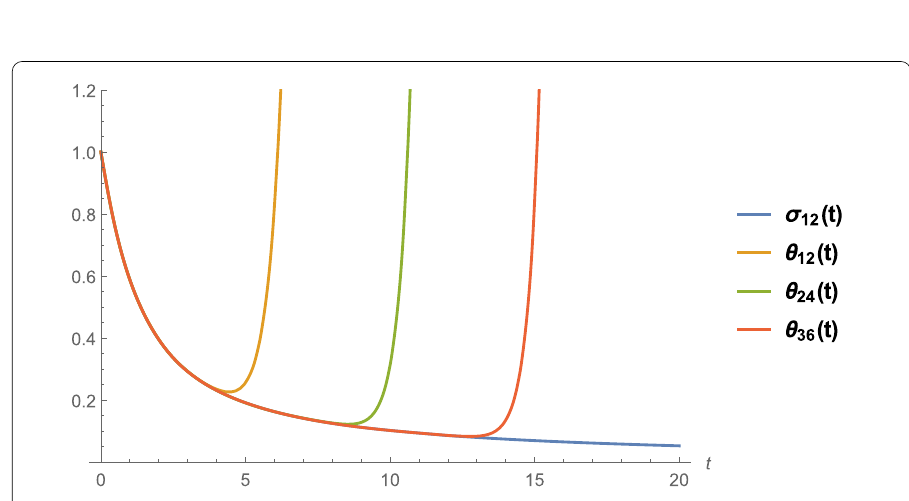
Figure 4 Comparison between σ 12 (present) and θ 12 , θ 24 in Ref. [42], and θ 36 at λ = 1, ξ = 2.5, and α = 1